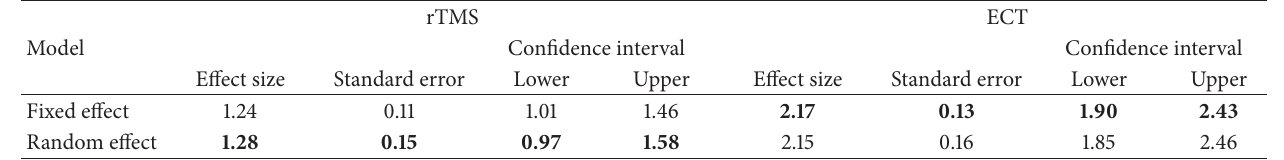
Table 3: Combined effect sizes for fixed and random effect